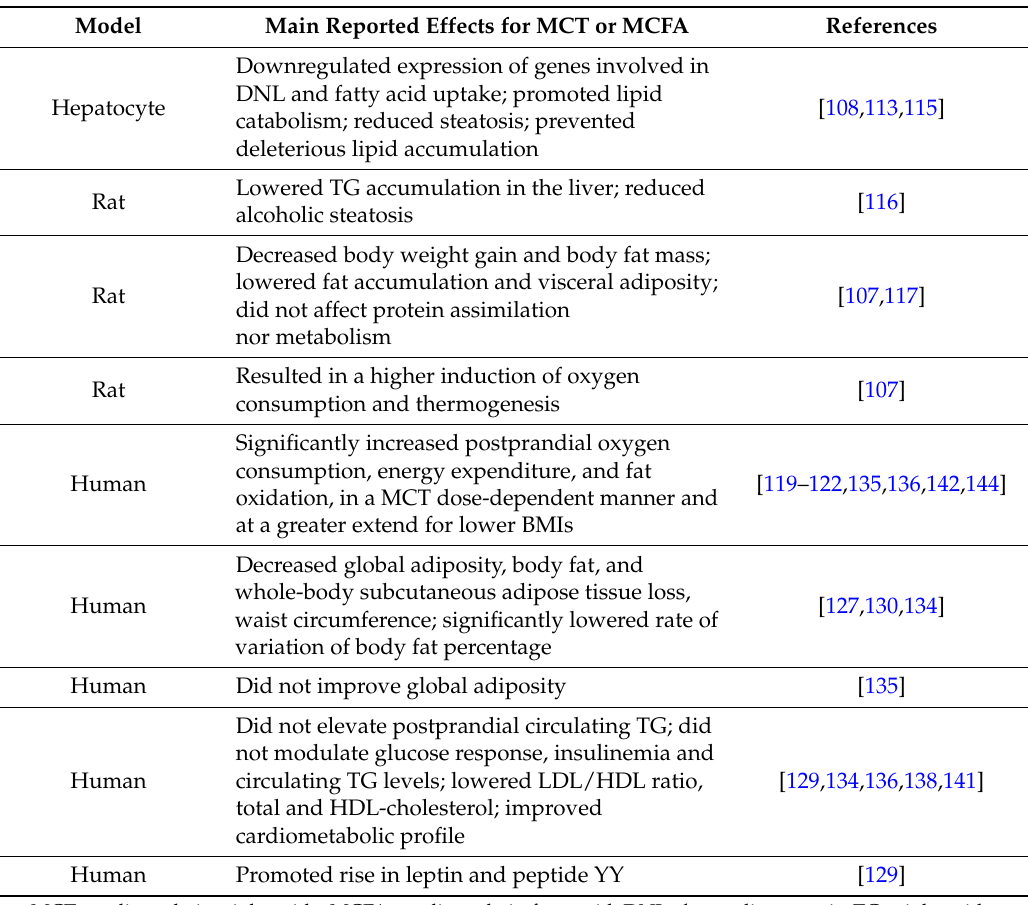
Table 1. Antiobesity effects of MCT and